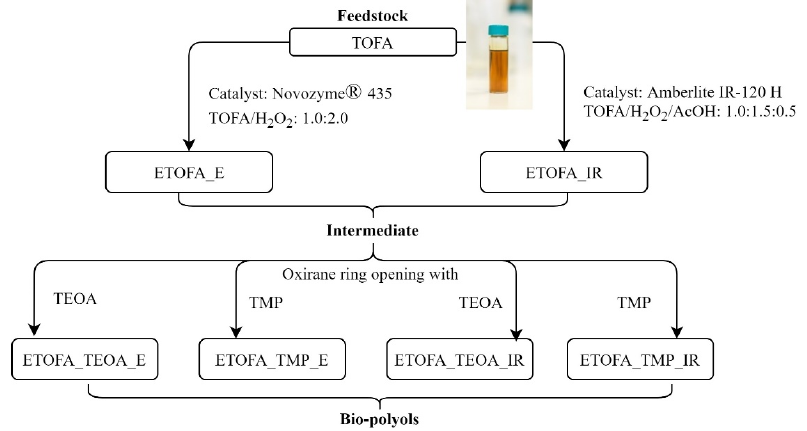
Figure 1. Scheme of developed tall oil fatty acids (TOFA)-based bio-polyols and intermediates.